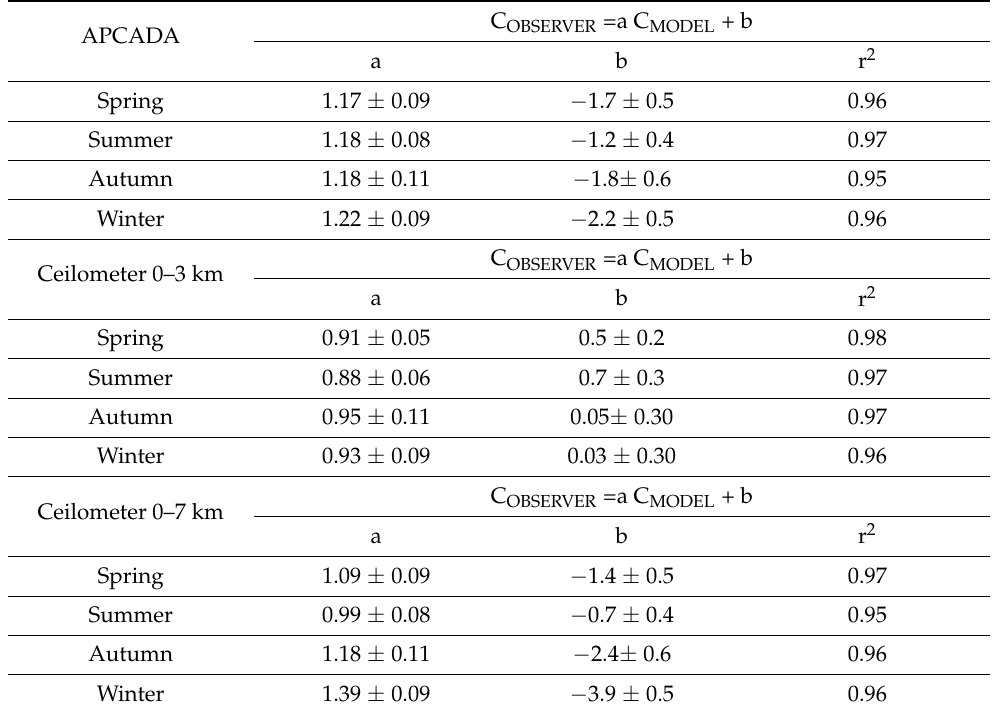
Table 3. Relationships between automatic and visual methods: linear regressions (low-medium cloud amount).